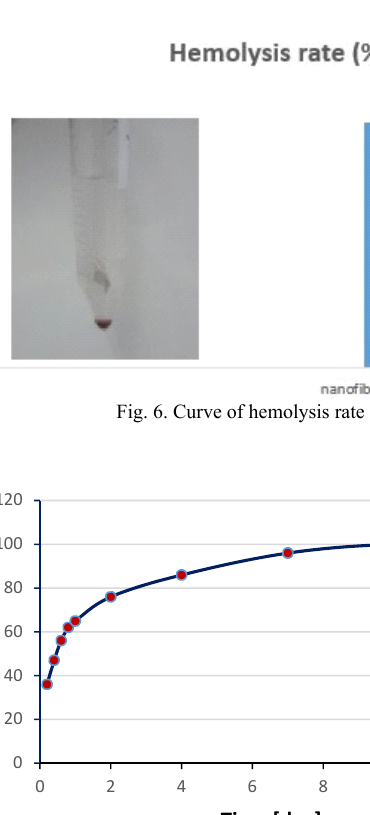
Fig.7. Release profile of vancomycin from the nanofiber scaffold with time